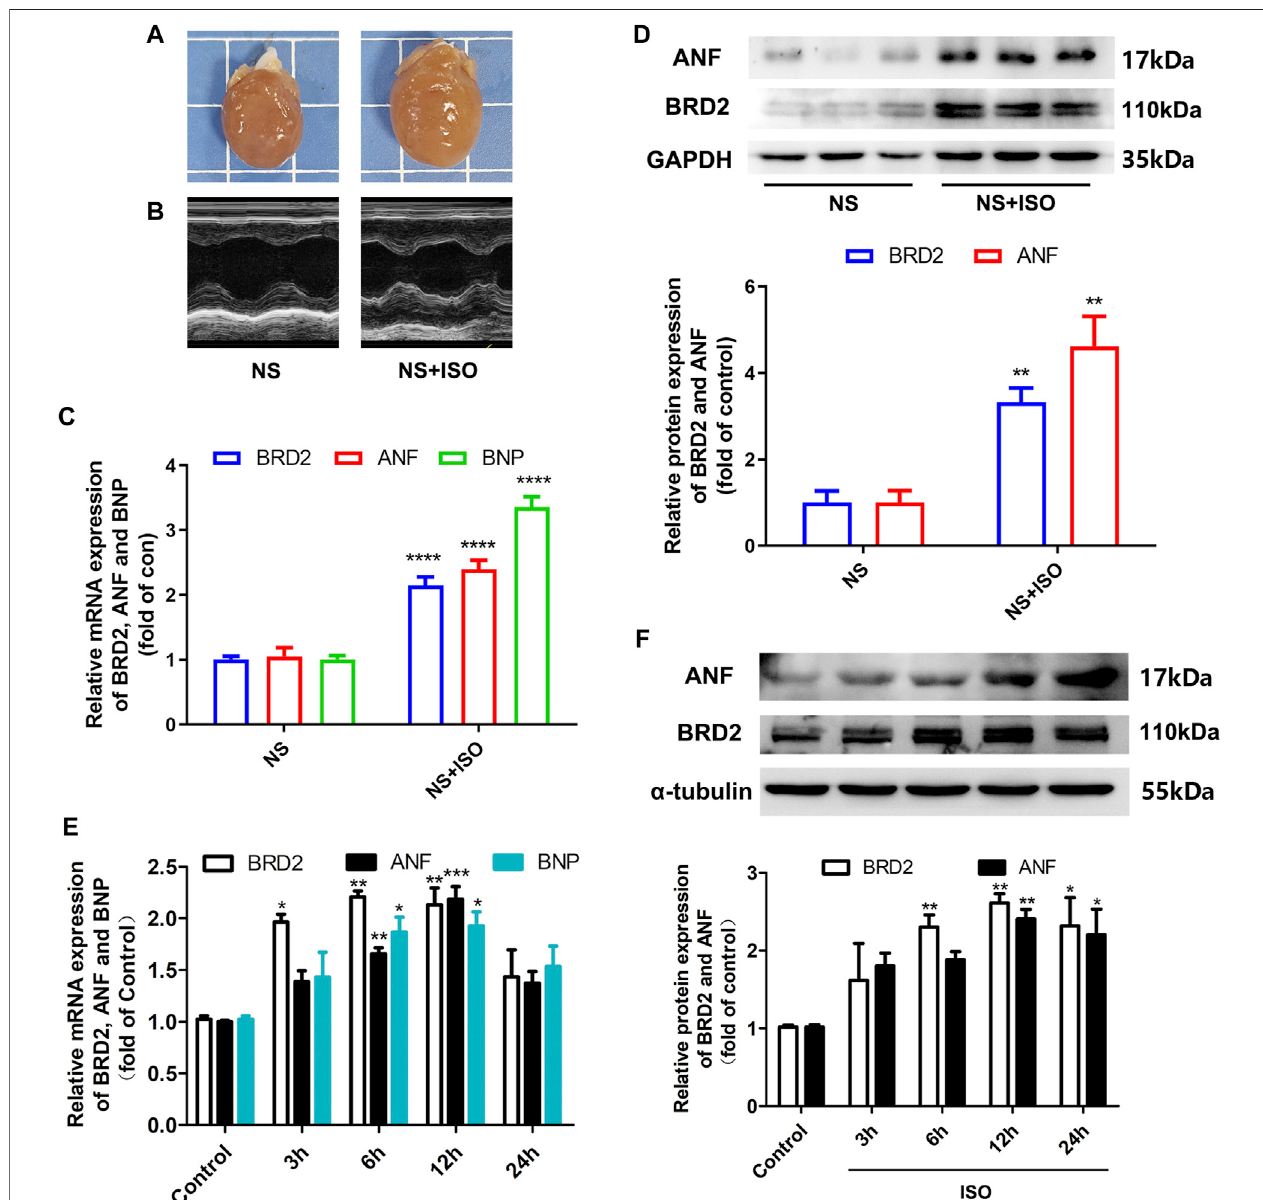
FIGURE 1 | BRD2 expression was elevated in ISO-induced cardiac hypertrophy. Hypertrophic changes of left ventricle in ISO-treated rats were observed by (A) grossmorphologicexaminationand (B) echocardiography. (C) ThemRNAand (D) proteinexpressionofBRD2,ANFandBNPinISO-treatedrats. (E) ThemRNAand (F) proteinexpressionofBRD2,ANFandBNPaftertreatmentof10 μ MISOforindicatedtimesincardiomyocytes.Thedatawerepresentedasmean±SEM,* p < 0.05,** p < 0.01, *** p < 0.001 vs. control, **** p < 0.0001 vs. control. n =